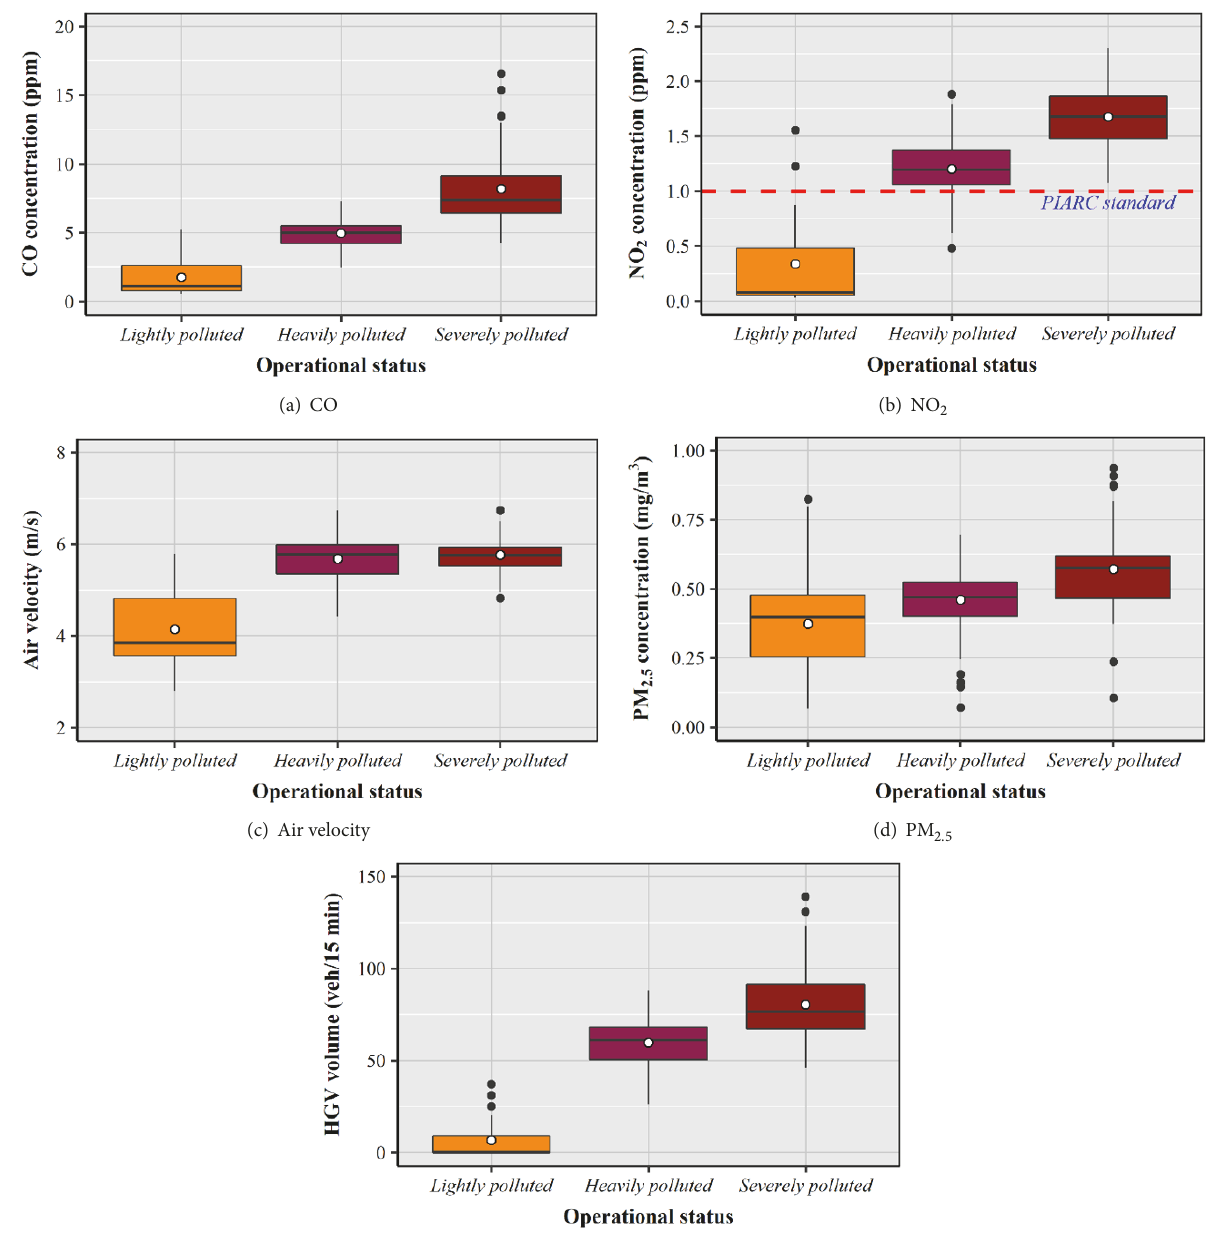
Figure 7: Distributions of particular variables under different